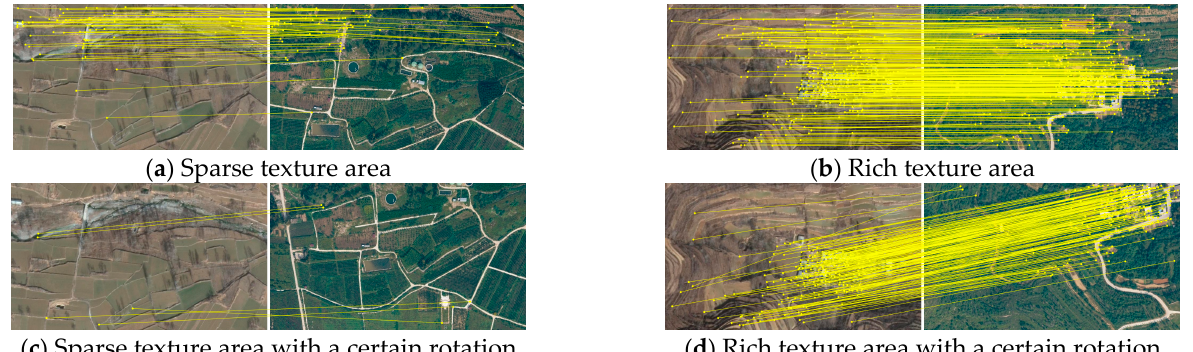
Figure 13. Partial matching results of Superpoint + Superglue on the test dataset.